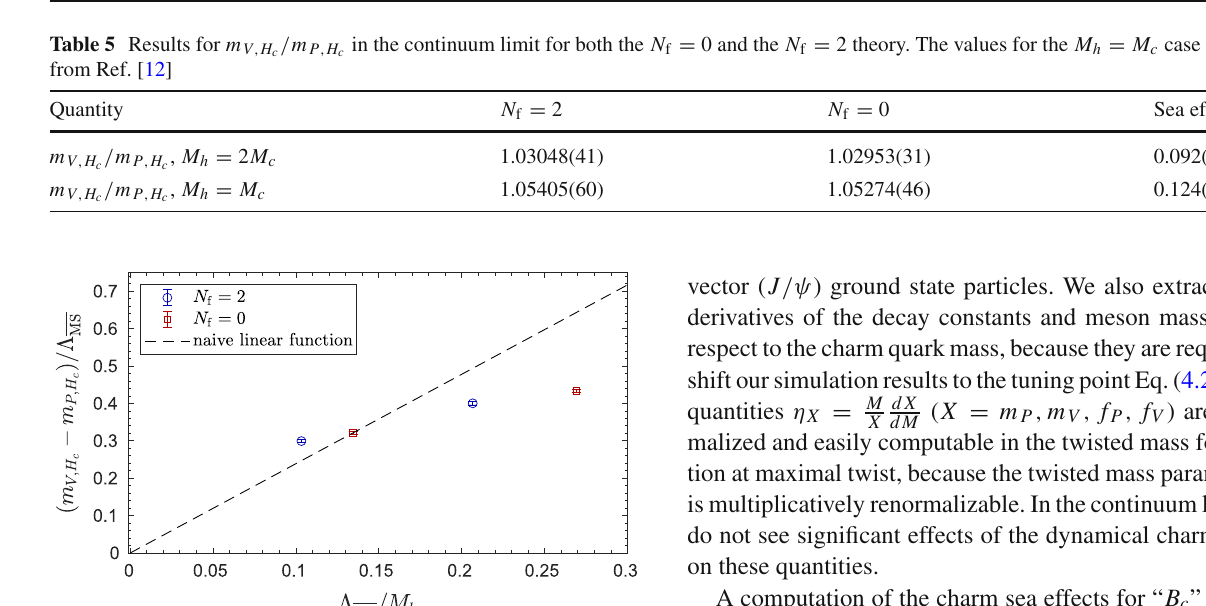
= M h c case are taken